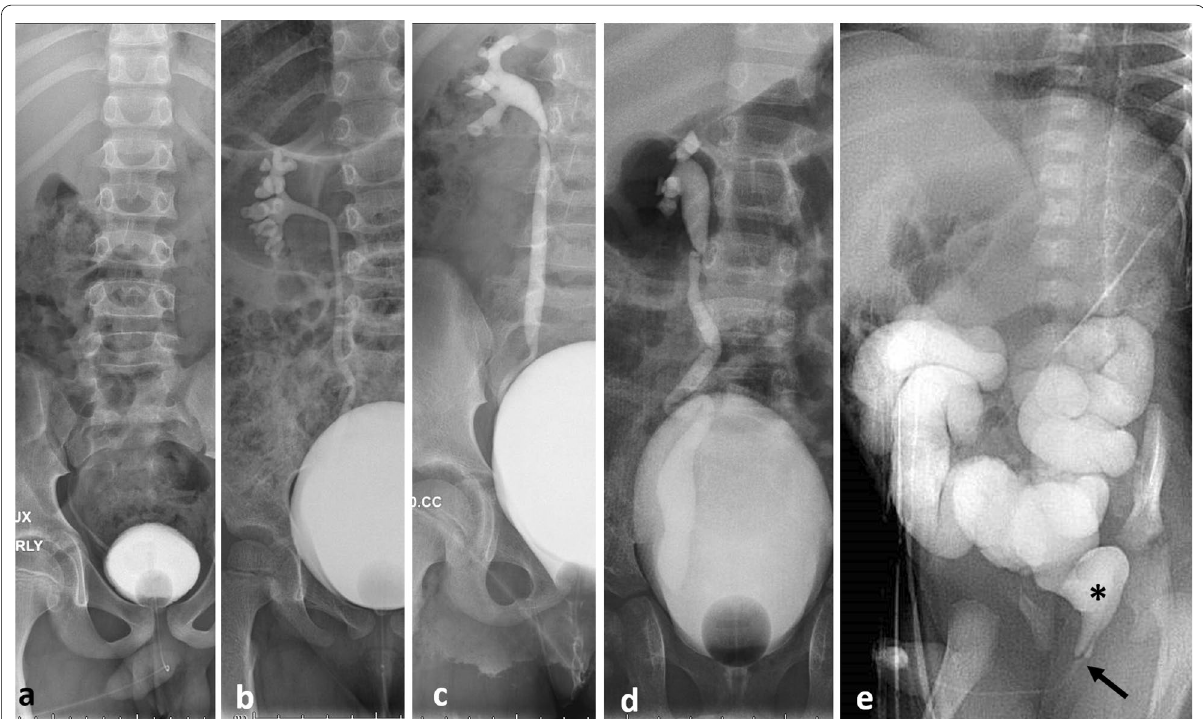
Fig. 2 different grades of vesicoureteral reflux elicited by micturating cystourethrography. Note bilateral grade 5 reflux and dilated posterior urethra (asterisk) in a case of posterior urethral valve